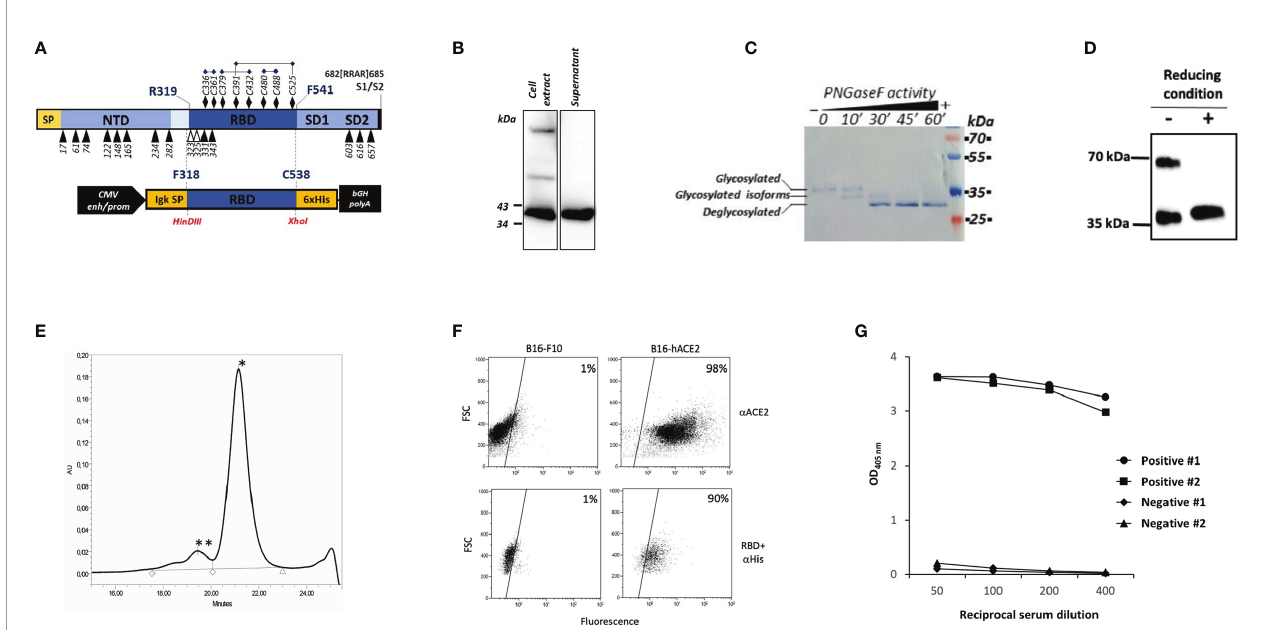
FIGURE 1 | Production and characterization of HEK293T rRBD. (A) Diagram of SARS-CoV-2 S1 domain and of the rRBD expression cassette in pIgkRBD 318-538 SARS-CoV-2 plasmid vector. Functional elements are indicated: SP (signal peptide), NTD (N-terminal domain), RBD, SD1 and SD2 (subdomain 1 and 2), CMV enh/ prom (human cytomegalovirus immediate early enhancer/promoter), Igk SP (murine Ig k -chain leader sequence), 6xHis (polyhistidine tag) and bGH polyA (bovine growth hormone polyadenylation signal). N-glycosylation and O-glycosylation sites are indicated by black and white respectively triangles. Cysteine residues are indicated by black diamond and disul fi de bonds are reported. (B – D) WB characterization of rRBD using an anti-Tetra His mAb. (B) Detection of rRBD in the cell extract and in the supernatant of transfected HEK293T cells. (C) Puri fi ed rRBD was denatured and digested with PNGase F in a time-dependent manner. The positions of glycosylated, deglycosylated and glycosylated isoforms of rRBD are indicated. (D) rRBD was denatured in SDS-loading buffer without b ME or with b ME. (E) SE-HPLC chromatogram of rRBD. The retention time suggests an approximate molecular mass of less than ∼ 40 kDa (*) corresponding to the monomeric form and another molecular mass of >150 kDa (**) corresponding to the aggregate multimeric structure. (F) rRBD binding to ACE2 receptor by fl ow cytometry. In the upper panels B16-F10 or B16 cells expressing human ACE2 receptor (B16-hACE2) were stained with anti-ACE2 mouse mAb and goat anti-mouse IgG PE- conjugated as secondary antibody. In the lower panel cells were incubated with rRBD and then stained with an anti-histidine mouse mAb revealed with goat anti- mouse FITC-conjugated mAb. The numbers indicate the percentages of positive cells. Each panel from (B – F) shows a representative experiment repeated at least two times. (G) Binding of serial dilution of human serum from two COVID-19 positive and two negative subjects on rRBD coated to the ELISA plate. Graph reports results obtained by two out of seven positive and seven negative